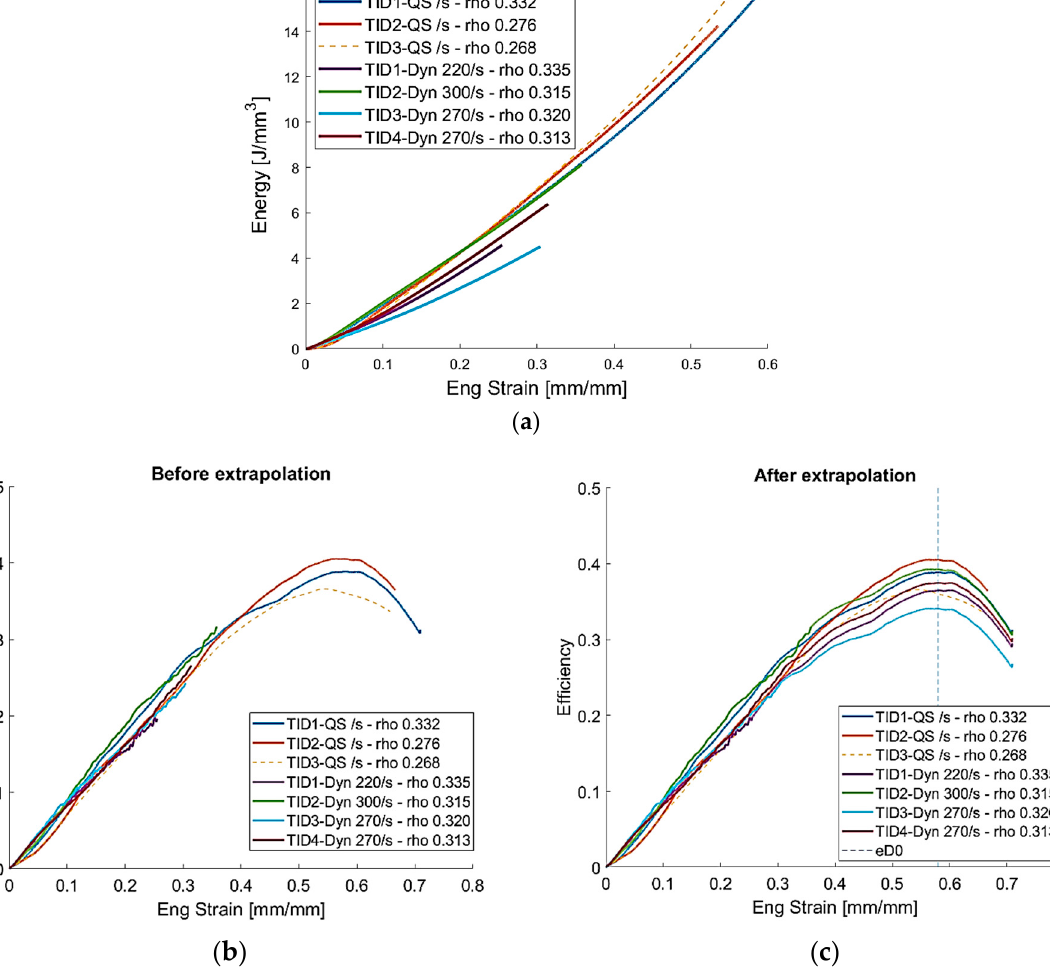
Figure 11. ( a ) Foam energy absorption and ( b ) efficiency before and ( c ) after